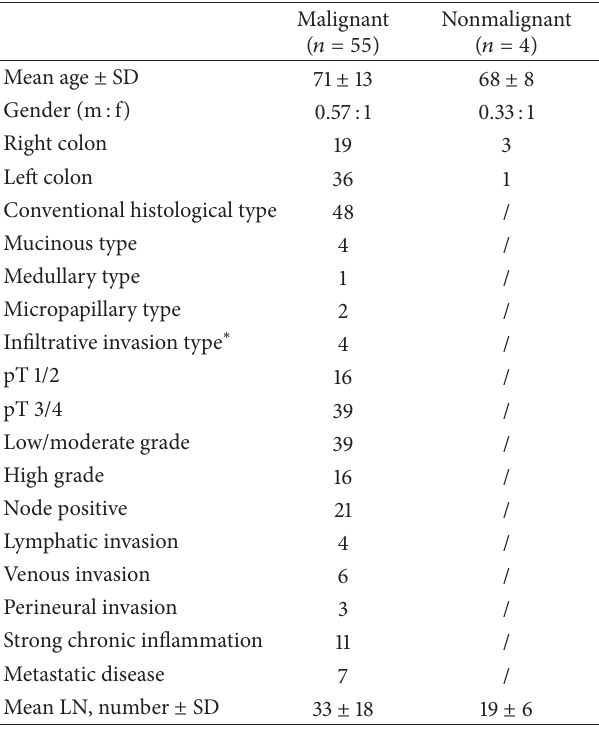
Table 1: Clinicopathologic data: test